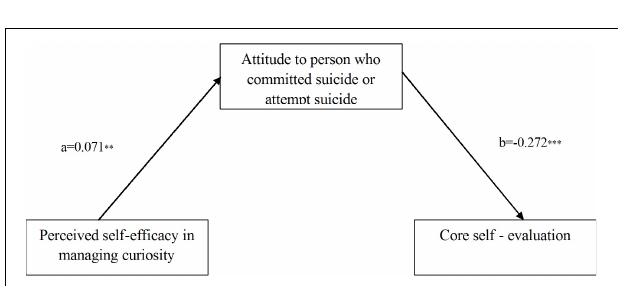
FIGURE 2 | Mediation effect diagram for attitude toward a person who committed suicide or attempted suicide.